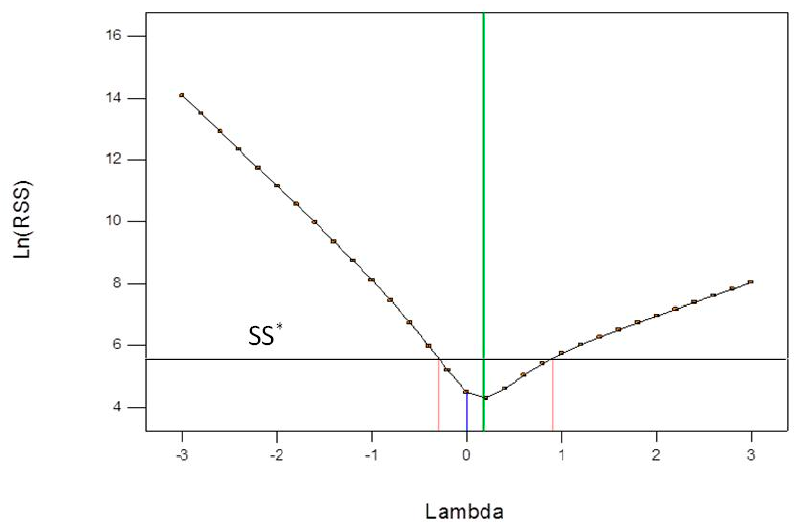
Figure C1. Box–Cox plot for the power transformation applied to %Fe(III) precipitation. Figure A6. Box–Cox plot for the power transformation applied to %Fe(III)